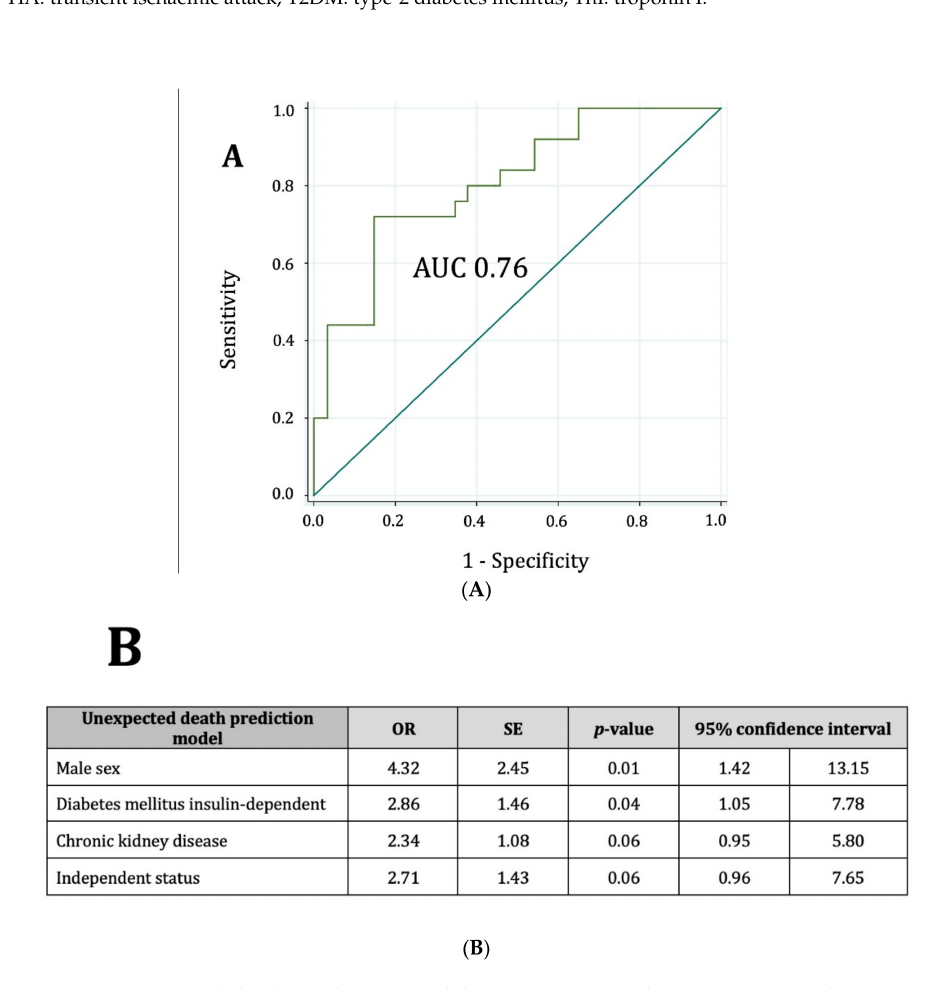
Figure 2. Unexpected death prediction model. ( A ) Represents the ROC curve with an area under the curve (AUC) of 0.75. Below, ( B ) Represents in a table the multivariable analysis with the corresponding values of odds ratio for each one of the four variables included in the model and their respective confidence intervals and p -values. OR: odds ratio, SE: standard